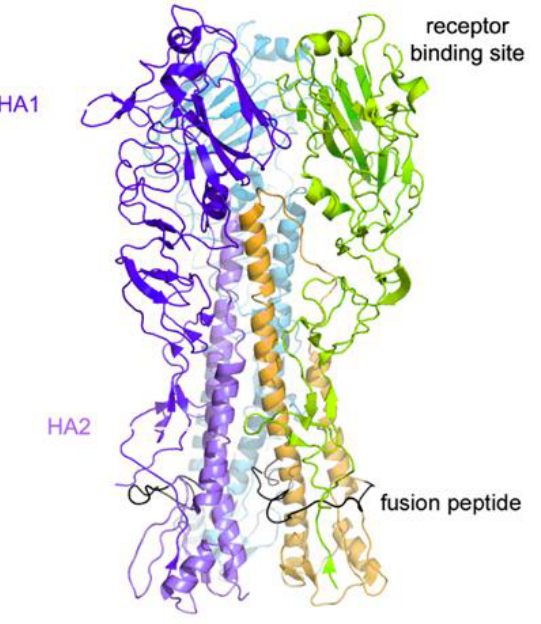
Figure 1. Cartoon representation of the HA trimeric structure.